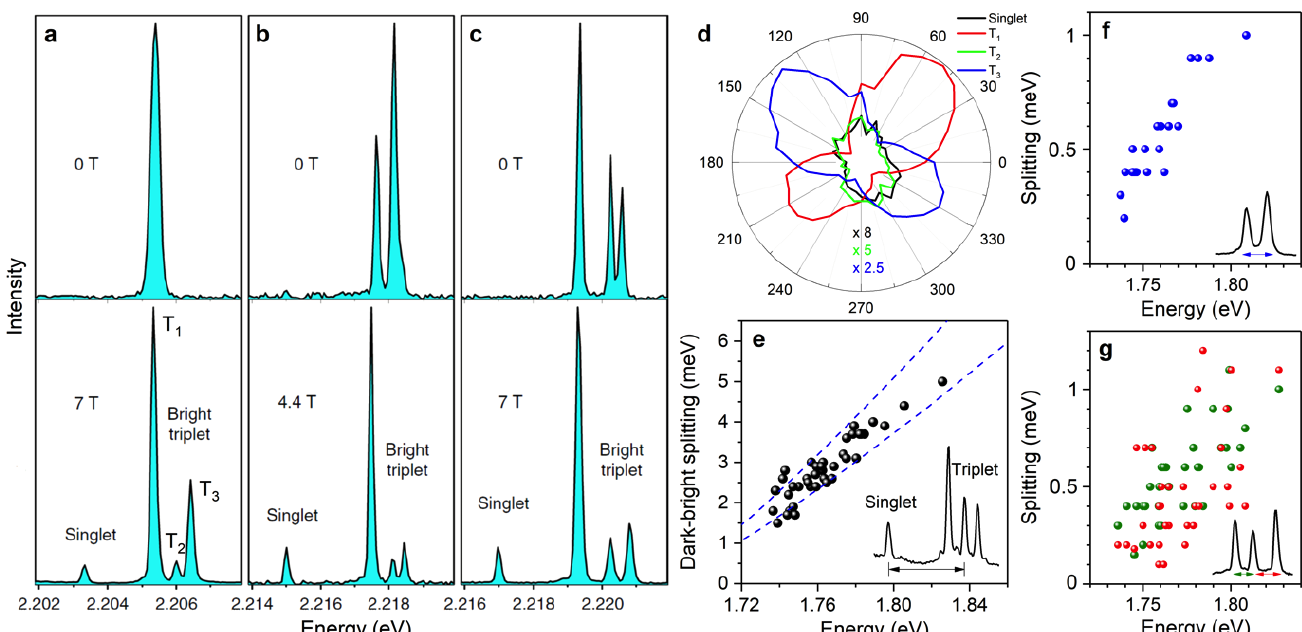
Figure 2. Entire exciton fine structure of single perovskite NCs. ( a – c ) Low-temperature PL spectra of three different FAPbBr 3 NCs displaying one line ( a ), two lines ( b ) and three lines ( c ) in zero field (upper panels). Their conversion under magnetic fields into four-line spectra (lower panels) reveals the entire fine structure, especially the lowest-energy dark singlet exciton state. ( d ) Polarization analysis of the emission lines of the FAPbBr 3 NC shown in ( a ). The triplet ZPLs are denoted as T 1 , T 2 and T 3 . ( e ) The splitting between the singlet line and the central triplet line is plotted for many single CsPbI 3 NCs as a function of the energy of the emitted photons (taken at the central triplet line). The dashed blue lines are simulations of the electron – hole exchange interaction of NCs with a cubic shape, taking into account the two bounds of dielectric corrections associated with the sample boundaries. Top line: NC surrounded by vacuum; bottom line: NC surrounded by sapphire. ( f , g ) Zero-field triplet splittings of single CsPbI 3 NCs with two-line spectra ( f ) and with three-line spectra ( g ) as a function of the energy of the lowest ( f ) or central ( g ) exciton line. Adapted with permission from ref. [42]. Copyright 2019 Springer Nature. Also adapted from ref. [40].